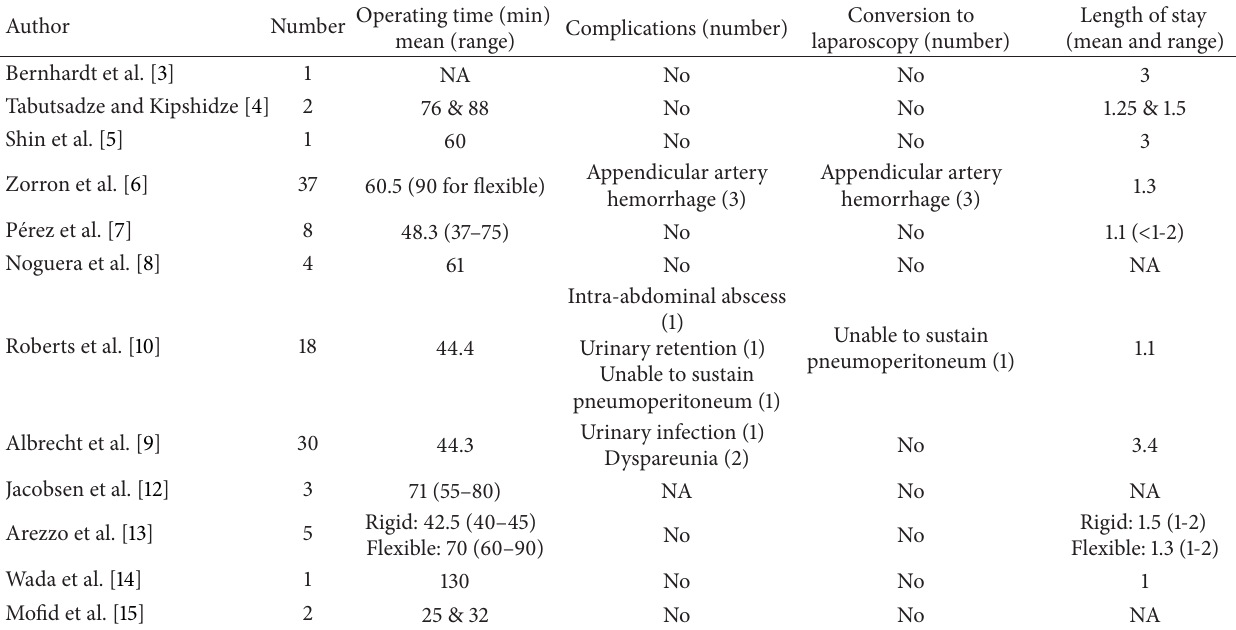
Table 3: Results of transvaginal